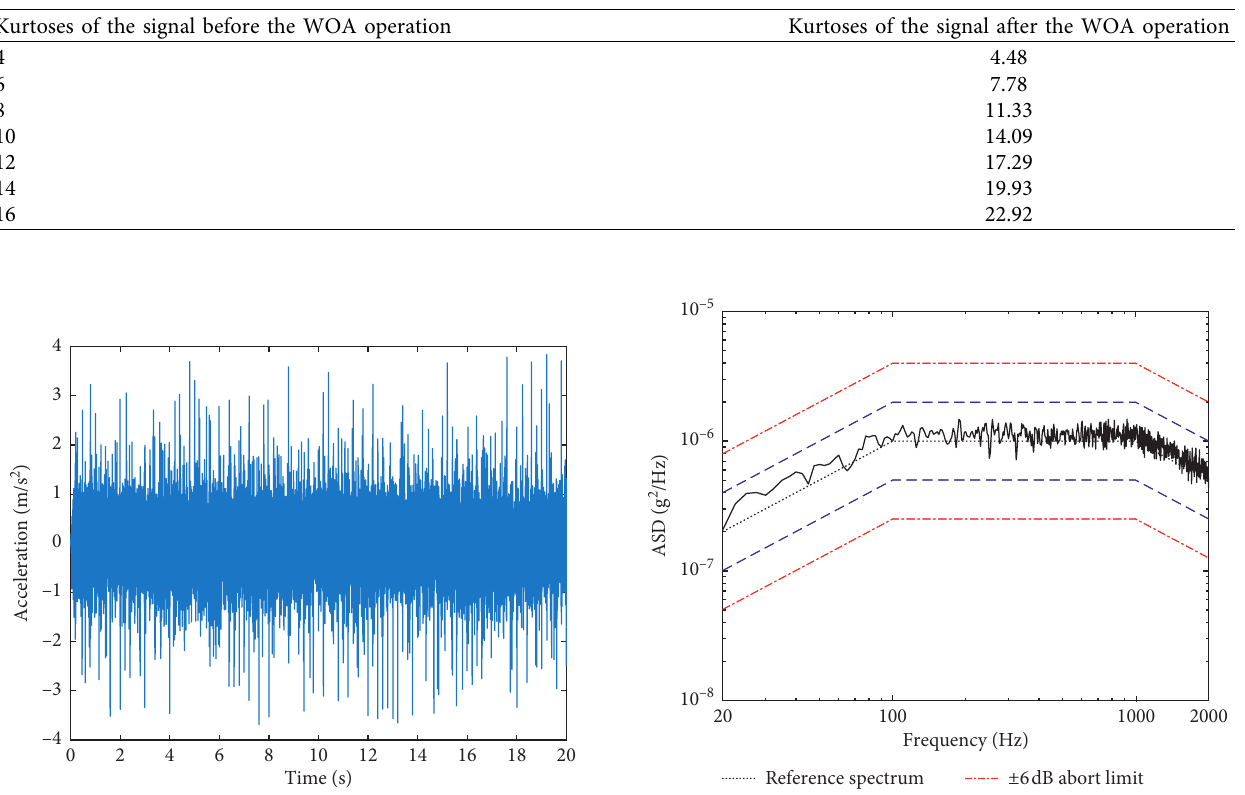
Figure 16: Fifty blocks of super-Gaussian responses with high peaks relocated in the middle of every frame. Figure 17: ASD of the super-Gaussian